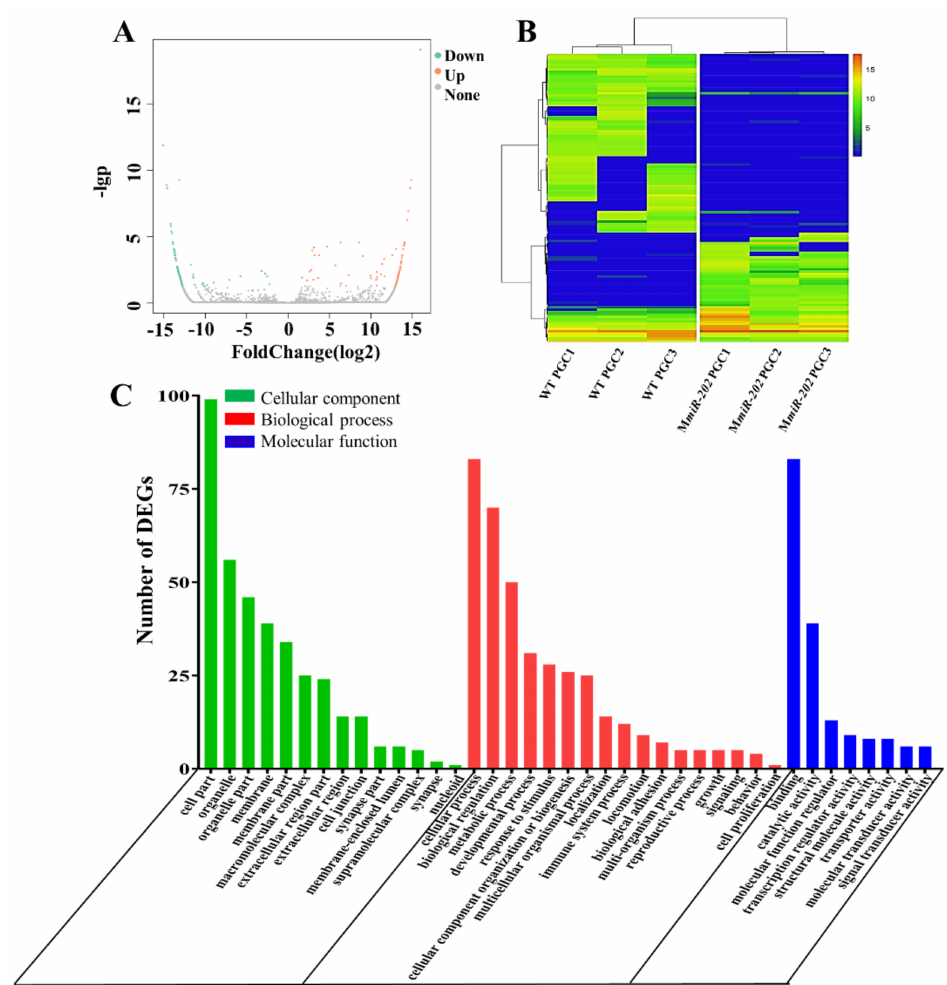
Figure 1. The expression pattern and GO annotation of DEGs. ( A ) Volcano plot of DEGs in WT and M miR-202 PGCs. The up-regulated and down-regulated DEGs were respectively shown as red and green dots. ( B ) Heatmap for the cluster analysis of DEGs in WT and M miR-202 PGCs. ( C ) The Gene Ontology annotation of all DEGs. The X-axis represents the 39 subcategories. The Y-axis shows the number of